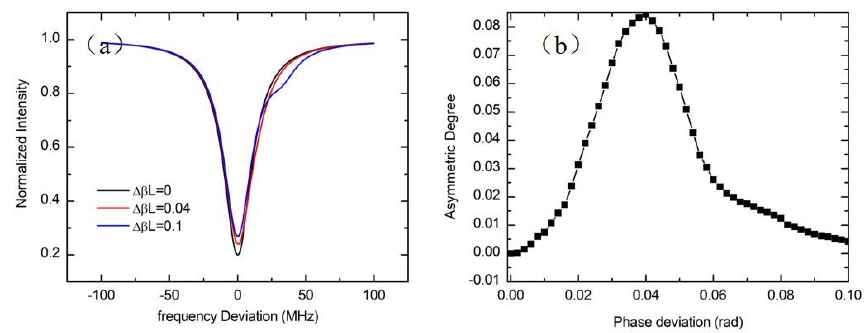
Figure 17. ( a ) Simulated resonance curves with different polarization phase deviation; ( b ) the influence of the phase deviation between two polarization states on the resonance asymmetry degree.